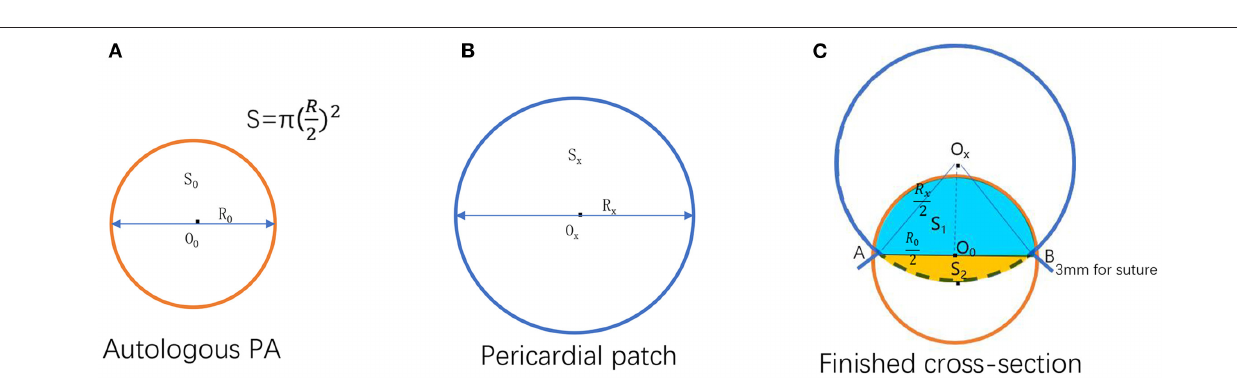
and valve leaflets. For individualized reconstruction of the RVOT, an autologous pericardial patch of appropriate size was harvested using a formula. As shown in Figure 2A is the cross-section of the autologous pulmonary artery, while Figure 2B is a fictitious circle formed by the pericardial patch before the procedure. The two circles’ total area equals the pulmonary annular cross-sectional area to be attained after